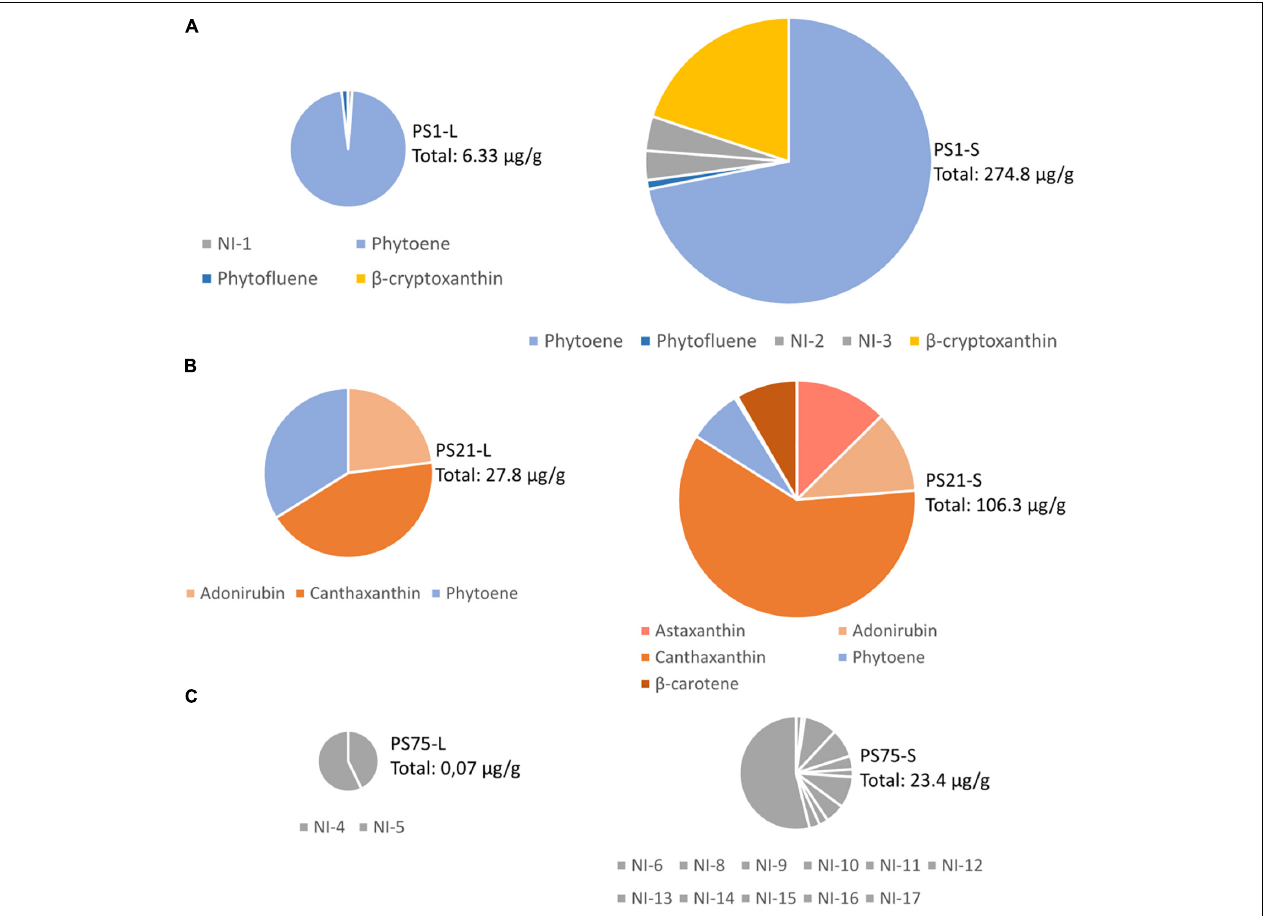
FIGURE 3 | Tentative identification and quantification of the carotenoid content from the three selected isolates (A) PS1, (B) PS21, (C) PS75) after harvesting from liquid (L) or solid (S) culture. The total amount of CRTs is indicated next to each chart in µ g per gram of cellular pellet (dry pellet in the samples harvested from solid culture, and wet pellet in the samples harvested from liquid culture). Further details on the concentration of each carotenoid can be found in Supplementary Table 2